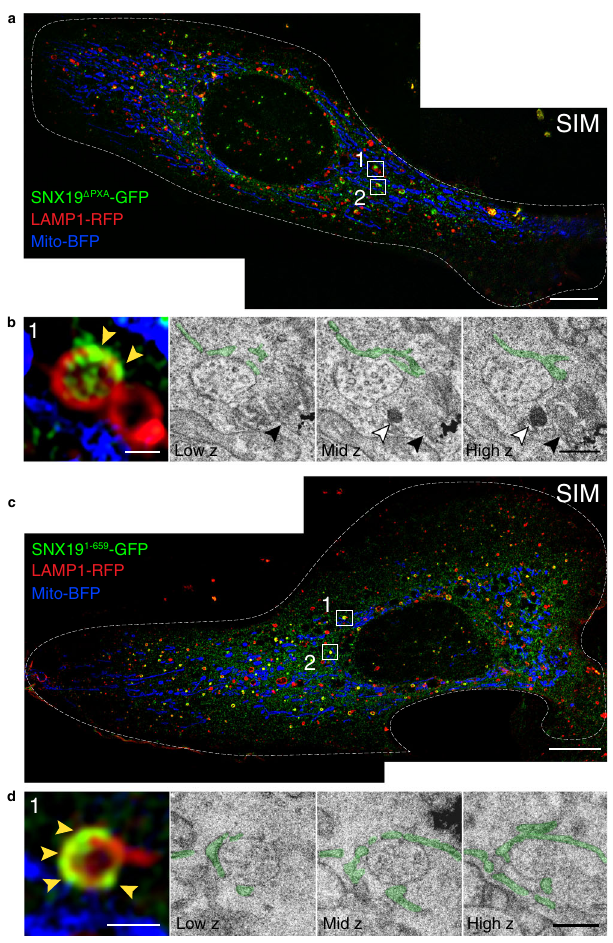
Fig. 4 CLEM shows localization of SNX19 hypertethers to ER – EL contact sites. a – d U-2 OS cells co-transfected with plasmids encoding LAMP1-RFP, Mito-BFP, and SNX19 Δ PXA -GFP ( a , b ) or SNX19 1 – 659 -GFP ( c , d ) were fi xed and imaged by structured illumination microscopy (SIM) and transmission EM. a , c SIM images are stitched and fl attened projections of 20 z slices each. Boxes 1 and 2 in each image show areas of interest that were further analyzed by EM. b , d Fluorescence micrographs show enlarged SIM images of contacts in box 1 from a , c . Yellow arrowheads point at SNX19 Δ PXA -GFP ( b ) or SNX19 1 – 659 -GFP ( d ) enrichment on LAMP1-RFP-positive ELs. The same contacts are shown in EM micrographs at 3 different z slices (right). Green shading highlights the ER. Black arrowheads point to a lysosome containing aggregated BSA-gold. White arrowheads point to a LD ( b ). Similar images of box 2 in a and c are shown in Supplementary Fig. 4a, b. Scale bars: 10 μ m in a and c , and 500 nm in b and d